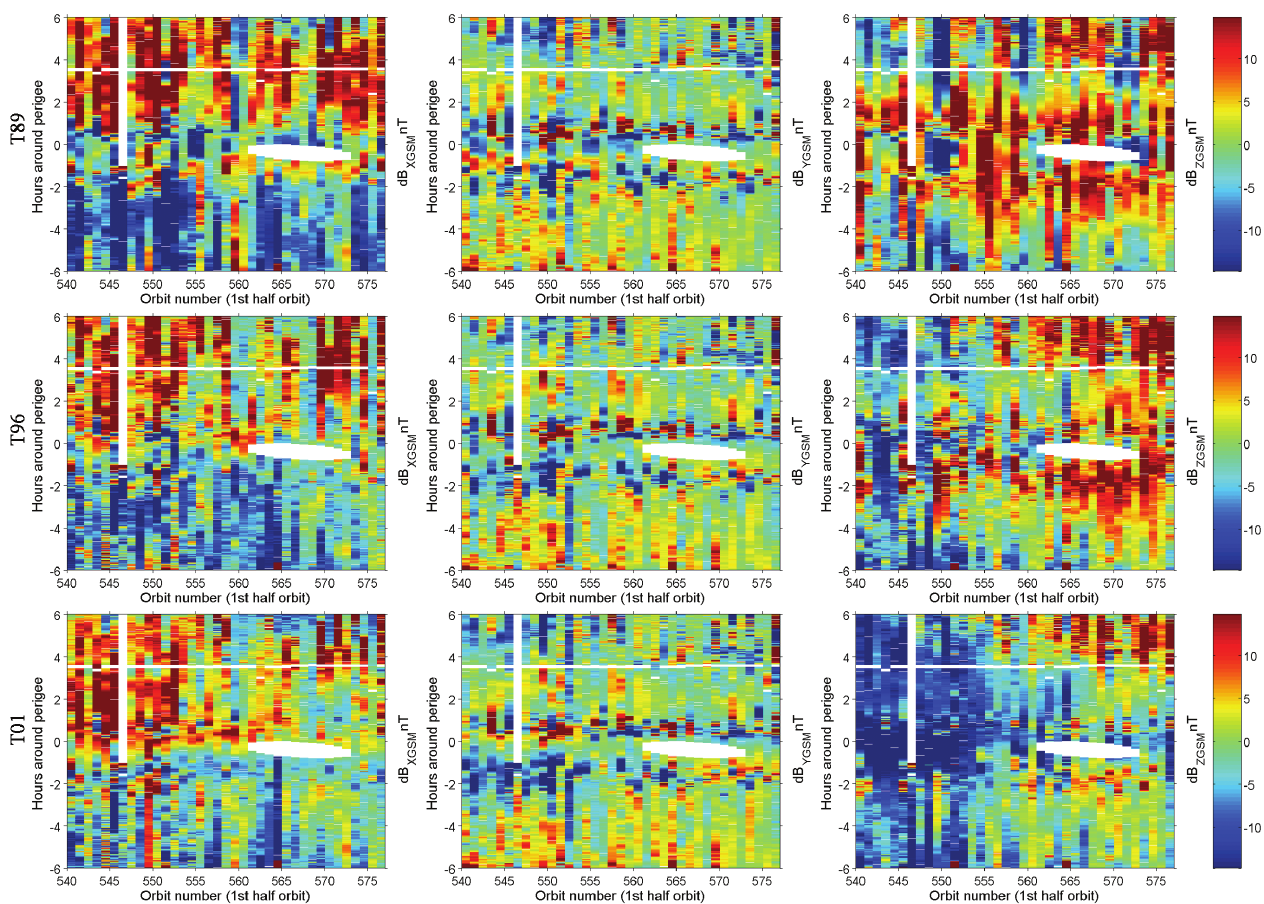
Fig. 6. Plots of the residuals from the comparisons of Cluster S/C 1 observations with T89, T96 and T01 models for the orbits 553–566 and 1014–1026, which are from 1st to 29 (28) February in 2004 and 2007,